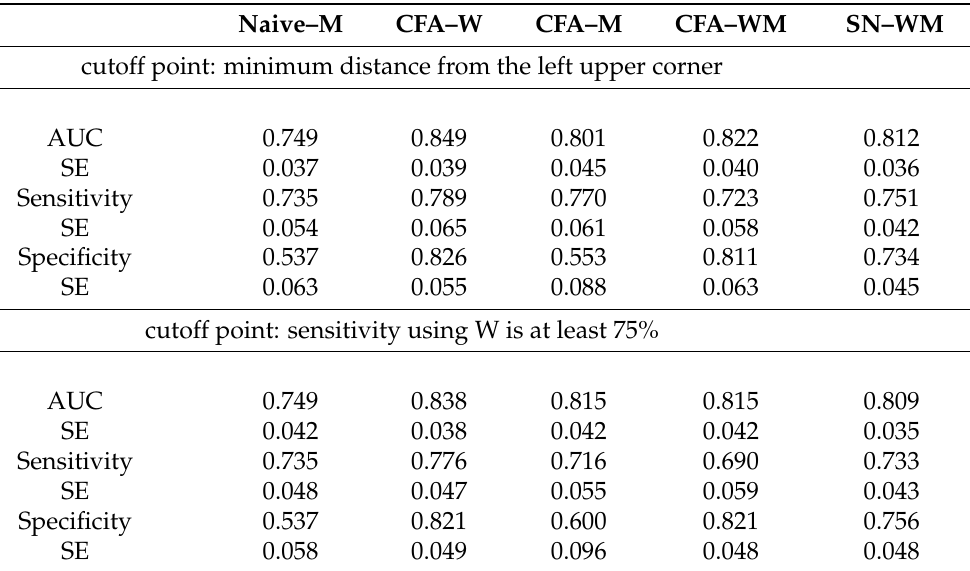
Table 4. Pancreatic ductal adenocarcinoma Data Analysis.